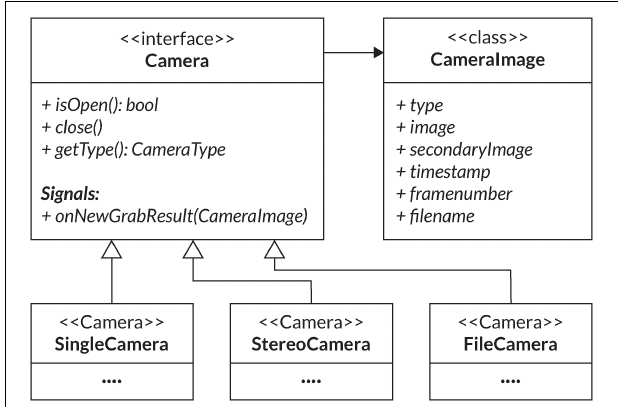
FIGURE 5 | UML diagram of the Camera interface and its implementations modeling for different types of cameras in the PupilEXT software. The CameraImage class is used to represent resulting images and their corresponding